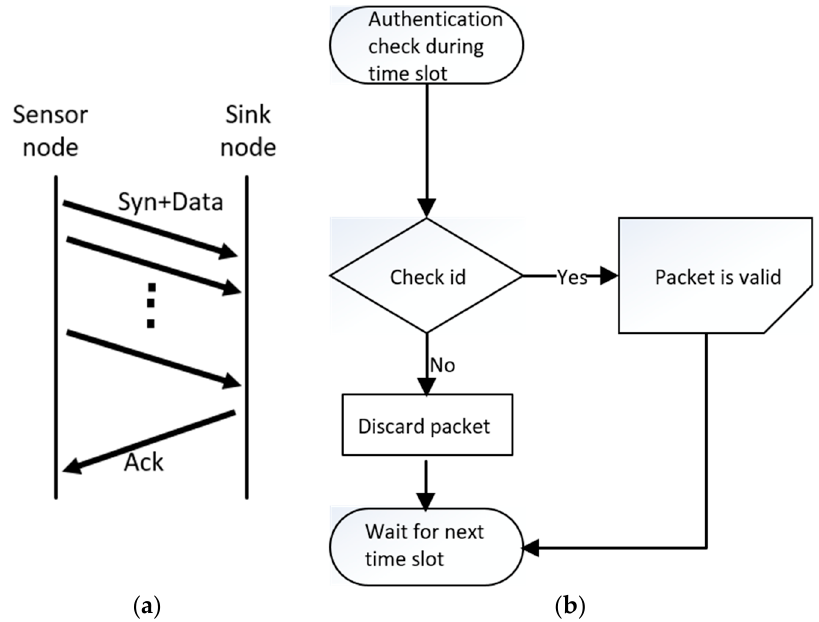
Figure 10. Operation mode during each time slot. ( a ) Step 1: automatic packet synchronization; ( b ) Step 2: identification check on valid packets by the sink node. ( b ) Step 2: identification check on valid packets by the sink